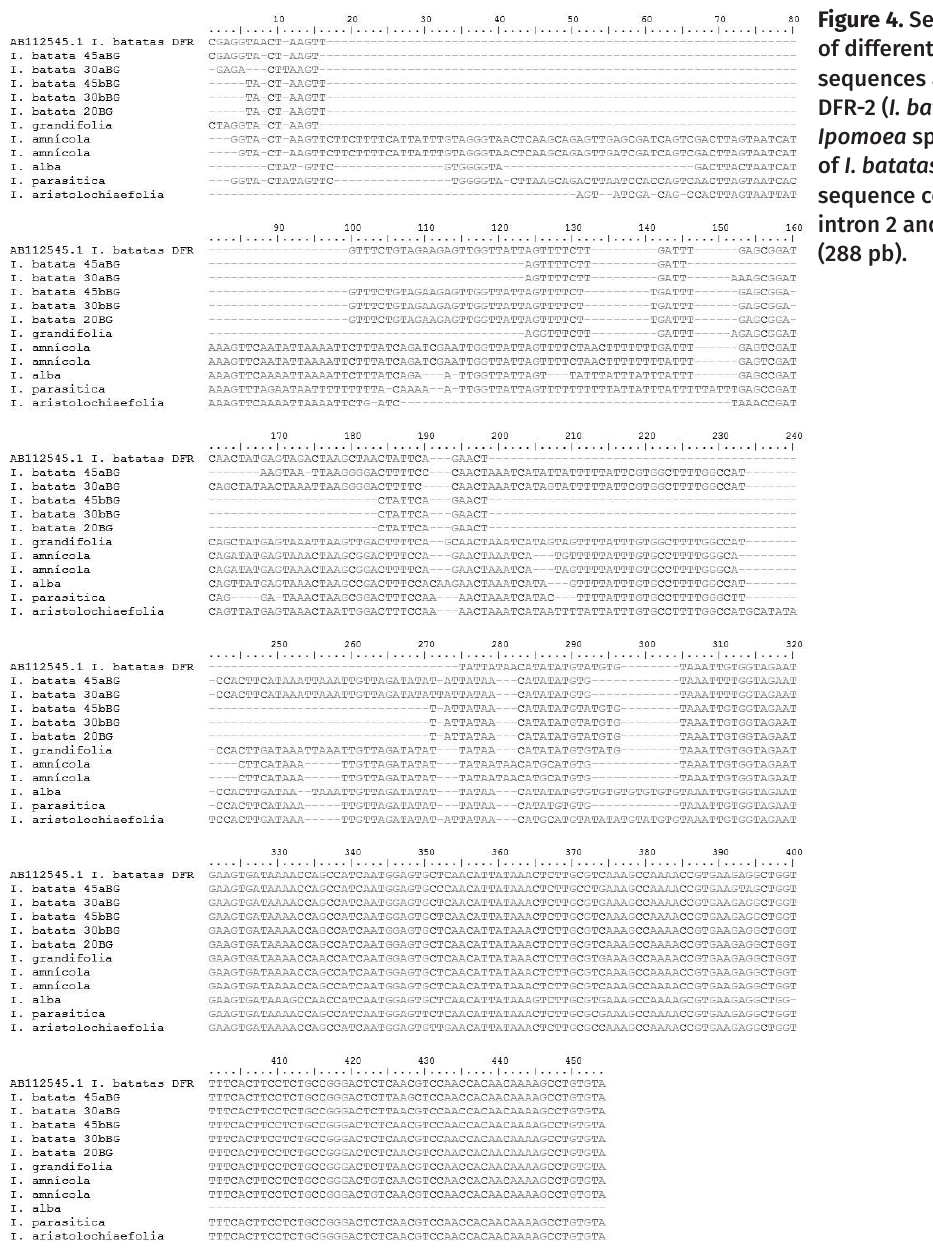
Figure 4. Sequence alignment of different genomic sequences amplifi ed with Ib- DFR-2 ( I. batatas and fi ve wild Ipomoea species) and mRNA of I. batatas (AB112545.1). The sequence corresponds to intron 2 and exon 3 regions (288